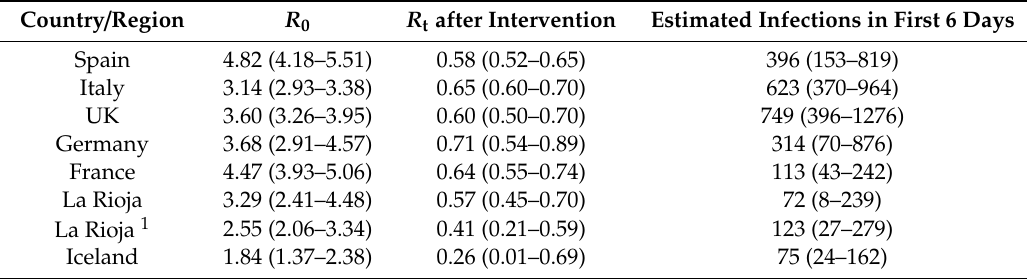
Table 3. Estimated reproduction numbers (before and after intervention) and initial number of infections resulting from the model (shown mean values, with 95% credible